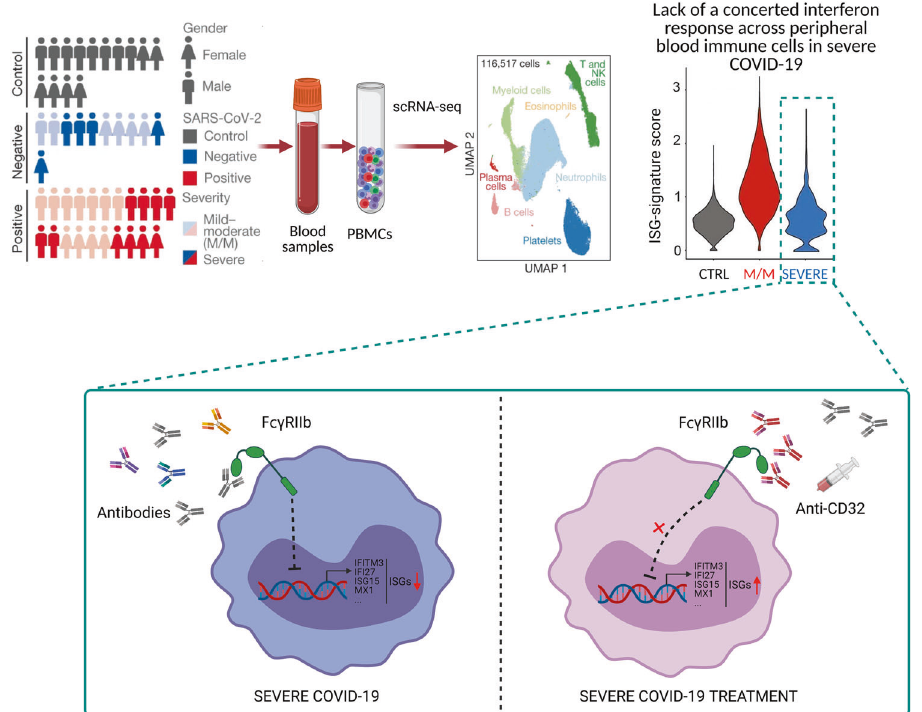
Fig. 1 Immune phenotyping of red-blood-cell-depleted blood samples but preserving all white blood cells and other serum components of patients with COVID19 using scRNA-seq analysis. Antibodies from patients with severe COVID-19 neutralized ISG induction by binding of Fc γ RIIb to contribute to the damaging effects in the suffered. Blocking the antibodies targeting Fc γ RIIb restored the induction of ISGs in PBMCs to reduce the severity of disease in dying patients, ushering in an advancement of immune regulation in the most severe disease and indicating potential effective therapeutic